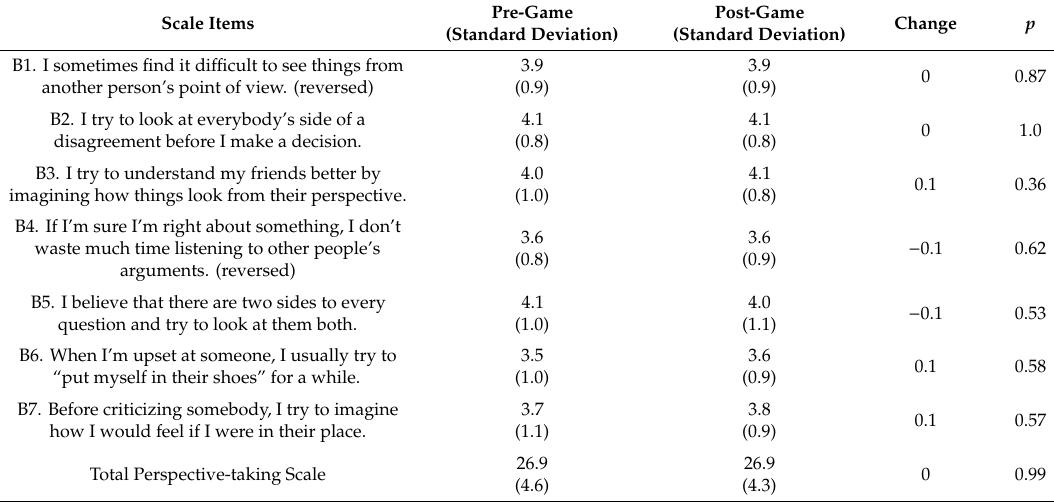
Table 3. Perspective-Taking. n =